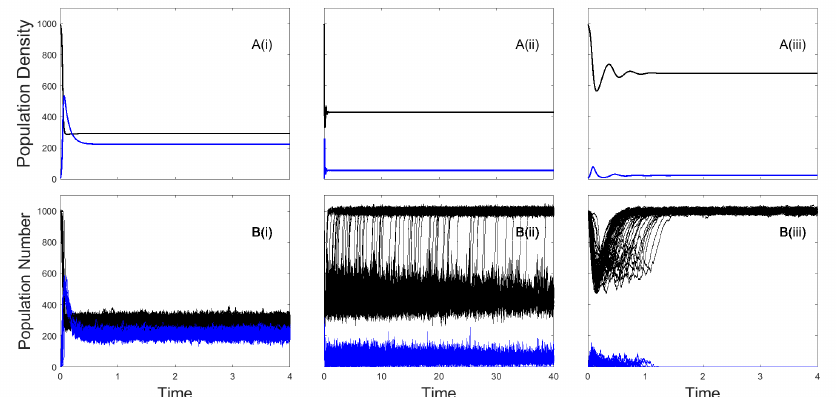
Figure 1. Population densities for the deterministic (Equation (1)) SIS model framework ( A ) and population numbers for the stochastic (Table 1) SIS model framework ( B ) with susceptible densi- ties/numbers (black) and infected densities/numbers (blue). For the stochastic model the results of 100 individual realizations are shown. Results are shown for three values of the disease-induced mortality rate ( i ) α = 10, ( ii ) α = 40 and ( iii ) α = 80, representing a low, medium and high mortality rate, respectively. Baseline parameter values (see Section 2) were used for other